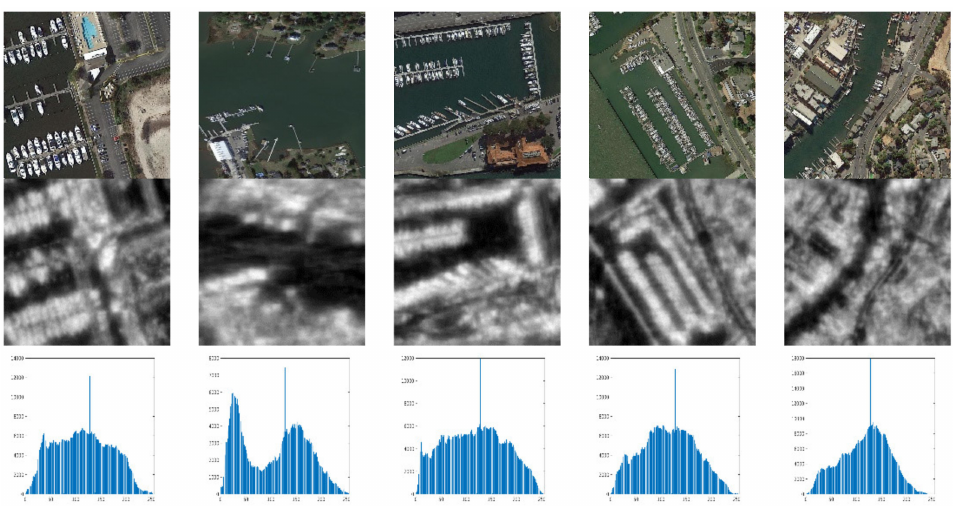
Figure 18. The saliency map and statistic histogram of some images in the testing dataset.